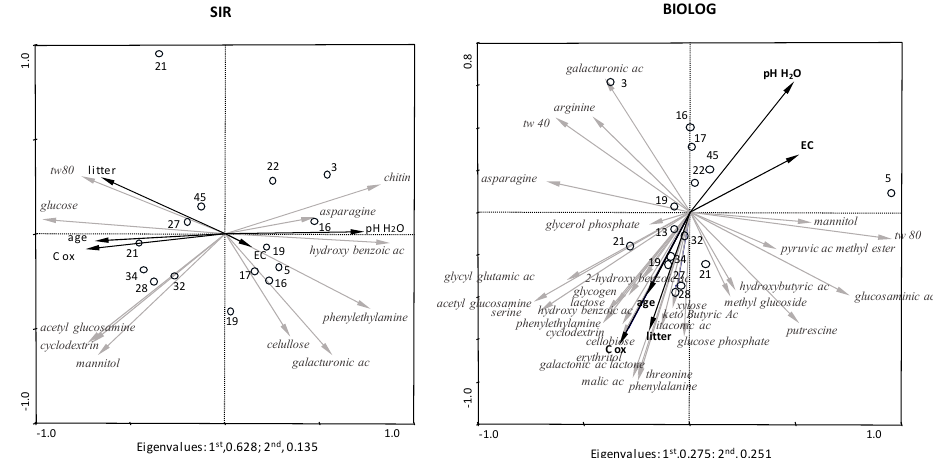
Figure 4. Principal component analysis (PCA) ordination diagram of individual substrates in Biolog and SIR with the options “standardization of sites” and “centering by substrate”. Circles represent individual sites. Narrow arrows represent substrates, bold arrows represent environmental variables. age: site age, C ox: oxidizable carbon, litter: litter mass, root: root mass, methyl glucoside: β -methyl-D-glucoside, galactonic ac lactone: D-galactonic acid g-lactone, arginine: L-arginine, pyruvic ac methyl ester: